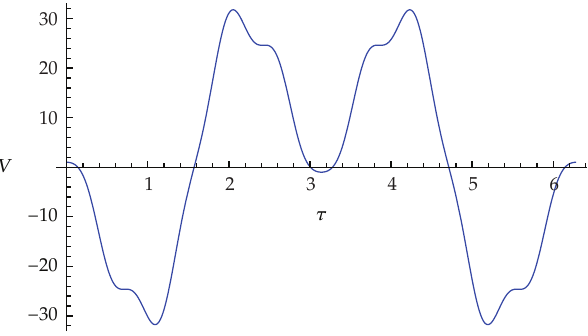
Figure 24: The evolution of the volume for (cid:2) 5.4 (cid:3) , n (cid:6) 10, α (cid:6)